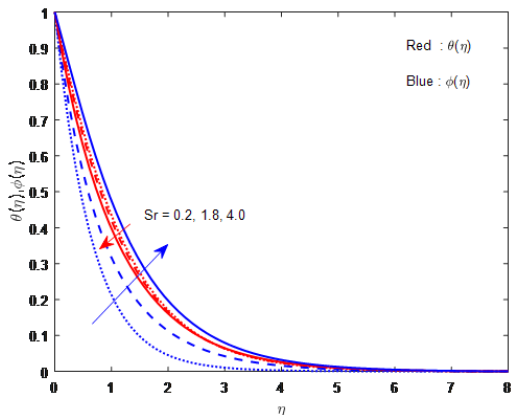
Figure 3: Temperature and concentration profiles for different val- ues of Casson parameter β